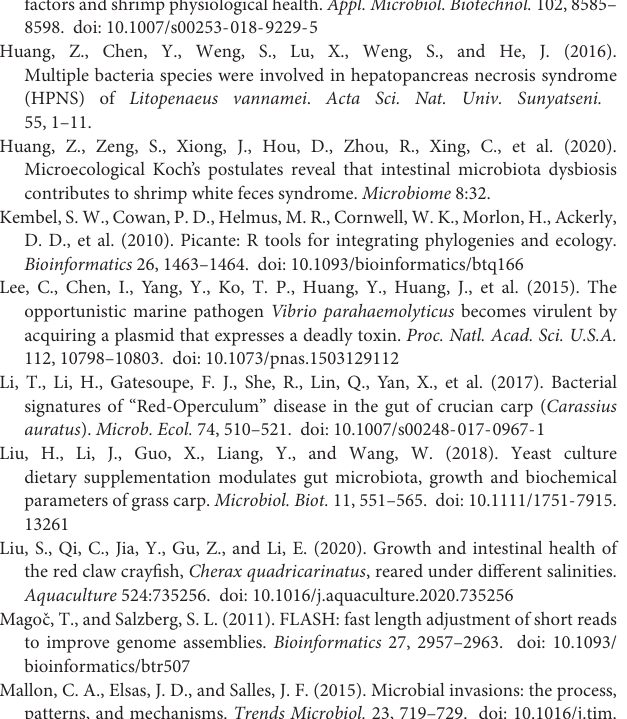
Supplementary Table S2 | Summary of sequence numbers and bacterial OTUs for shrimp intestine. Supplementary Table S3 | Bacterial α -diversity indices of shrimp intestine and statistical testing of these indices by the Welch’s t -test in the LS and HS groups. Supplementary Table S4 | Intestine core OTUs of shrimp in the LS and HS groups. The red word indicates that the species are core taxa both in two groups.